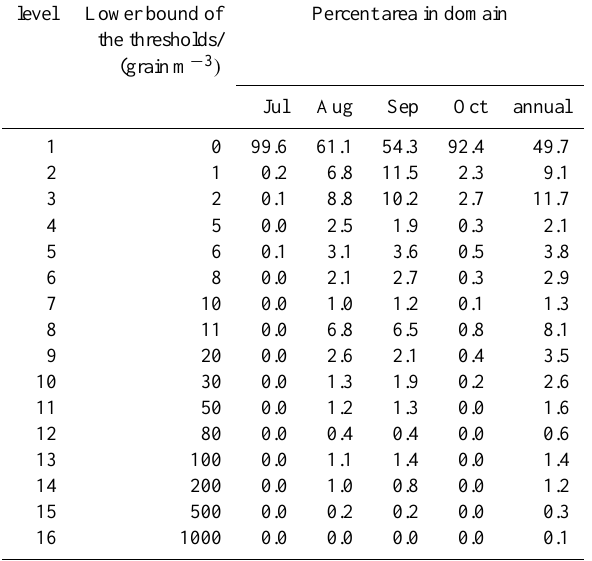
Table 4. Percent area with the surface concentration of ragweed pollen at different risk levels, average for